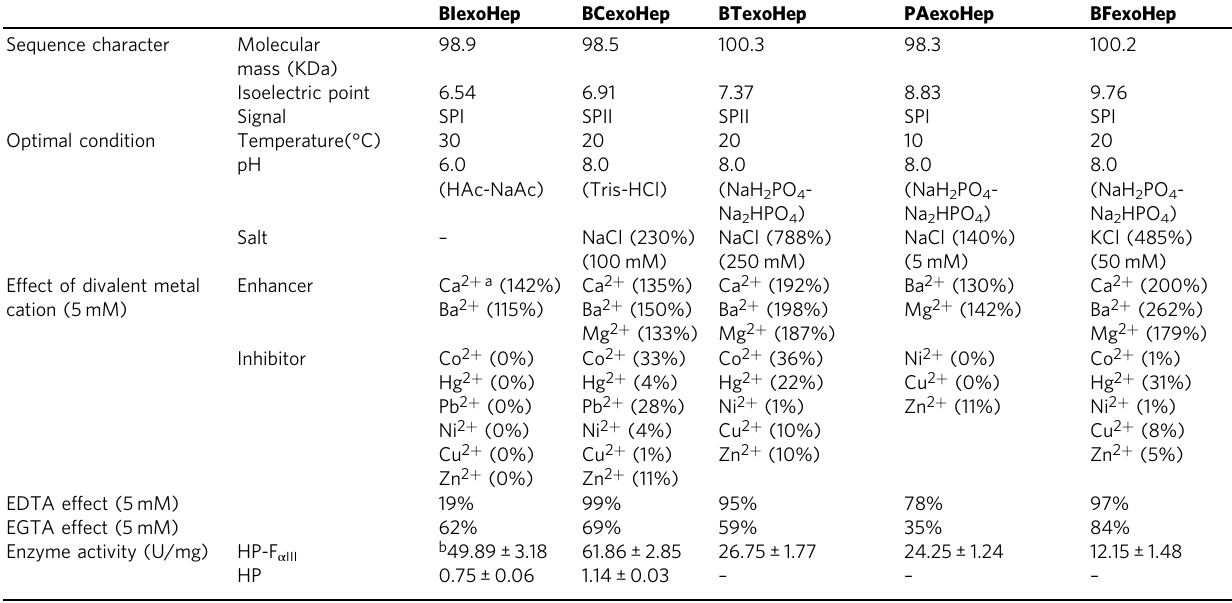
Table 1 Comparison of sequence and enzymatic properties of various PL15_2 family